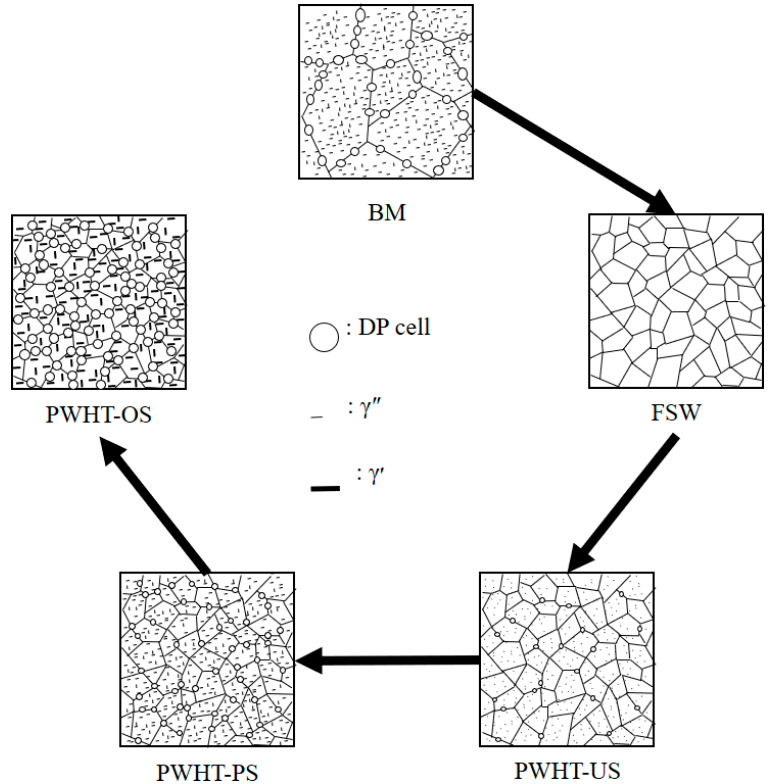
Figure 14. Schematic diagram of the evolution of the microstructure during the FSW and PWHT processes.